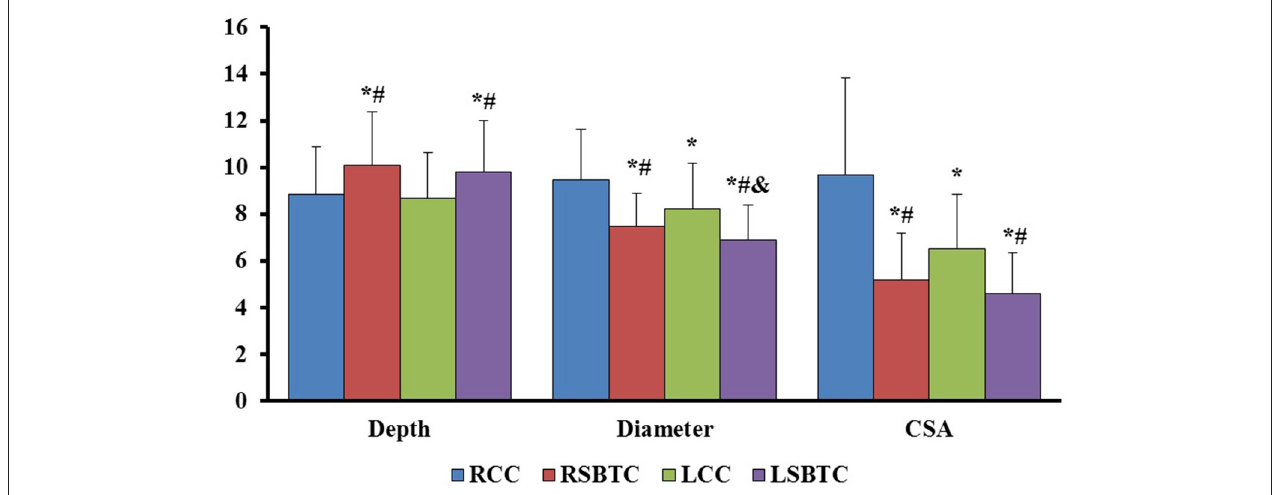
FIGURE 2 | The comparison of depth, MAPD, and CSA of bilateral internal jugular veins. RCC, right cricoid cartilage; RSBTC, right superior border of thyroid cartilage; LCC, left cricoid cartilage; LSBTC, left superior border of thyroid cartilage; MAPD, maximal antero-posterior diameter; CSA, cross-sectional area. The values of CSA were 10 times of realistic CSA measurements. * P < 0.01, compared with RCC; # P < 0.01, compared with LCC; & P < 0.01, compared with RSBTC.